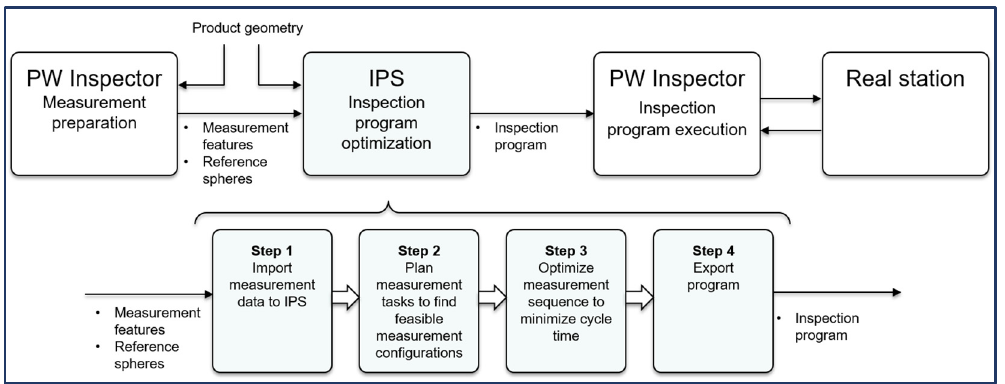
Figure 31. The evolved IPS laser radar process overview.